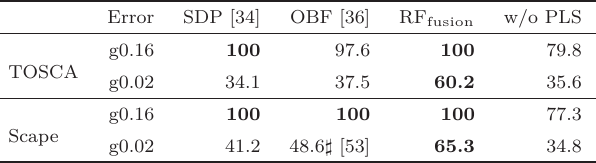
Table 4 Comparison of matching at 0.02 (g0.02) and 0.16 (g0.16) geodesic errors by the proposed RF fusion method with and